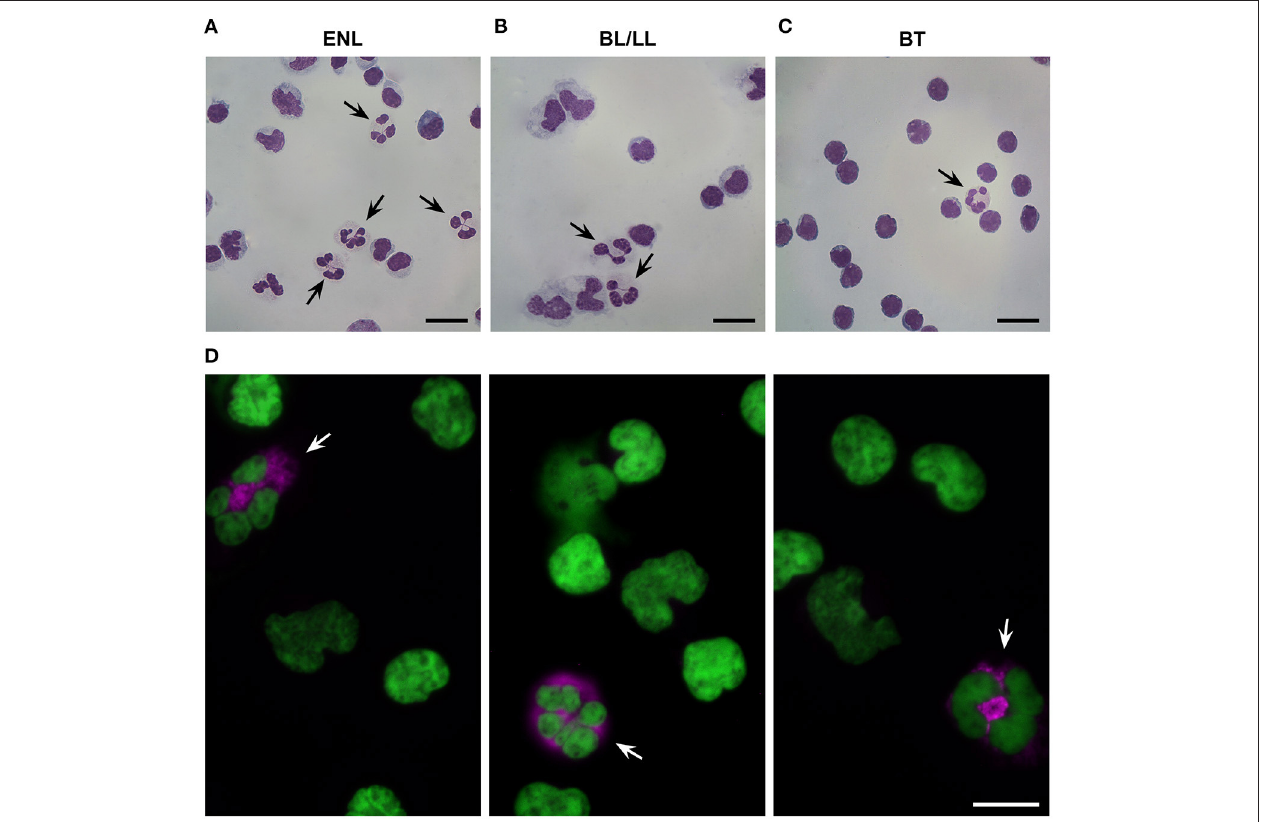
FIGURE 1 | Presence of low-density neutrophils in the peripheral blood of ENL patients. (A) Representative image of low-density neutrophils (LDNs) with a segmented nucleus within the peripheral blood mononuclear cell (PBMCs) layer of ENL patients ( n = 4). (B) BL/LL patients ( n = 3) and (C) BT patients ( n = 2). (D) Representative image of immunofluorescence in the PBMC layer of an ENL patient ( n = 3). LDNs were considered pentraxin-3-positive (PTX3 + ) cells. PTX3 (pink) and nucleus (DAPI, green). Arrows indicate LDNs. Scale bar = 10 µ